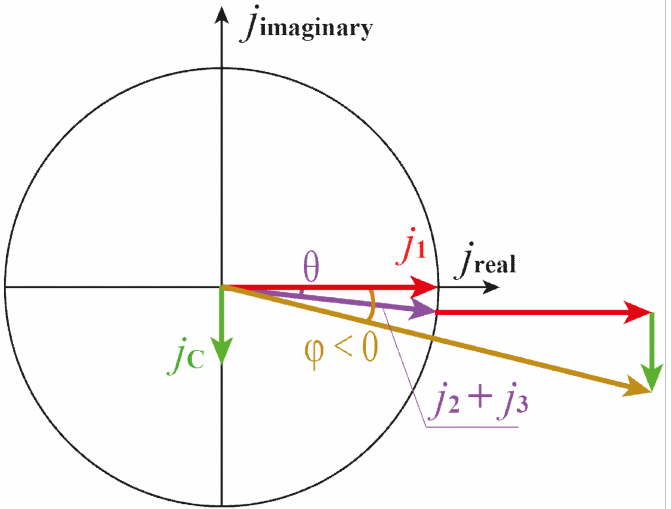
Figure 11. Indication diagram of current density for the case of dominant capacitive type conduction: j 1 —current density determined by Formula (17), j 2 + j 3 —current density determined by Formula (20), θ = – ωτ —angle between the vectors j 1 and ( j 2 + j 3 ), ϕ —phase shift angle determined by Formula (28).